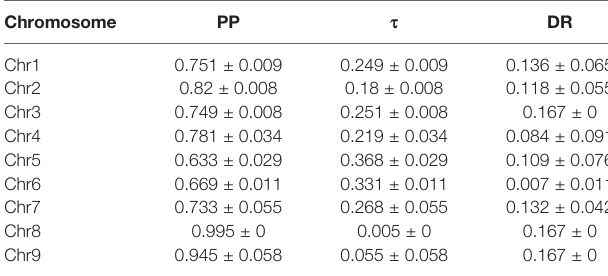
TABLE 3 | Estimation of PP and t from centromeric loci and DR from telomeric/ sub-telomeric loci of the nine chromosomes of ‘ Giant Key ’